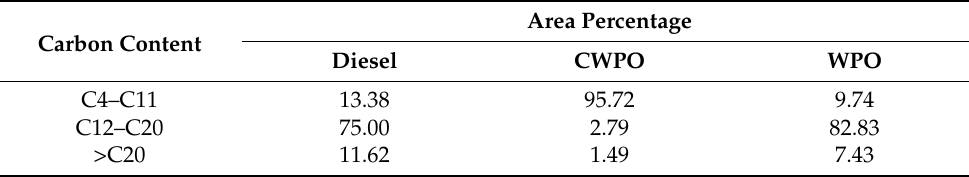
Table 4. Carbon content of the test fuel compared with diesel fuel by GC–MS